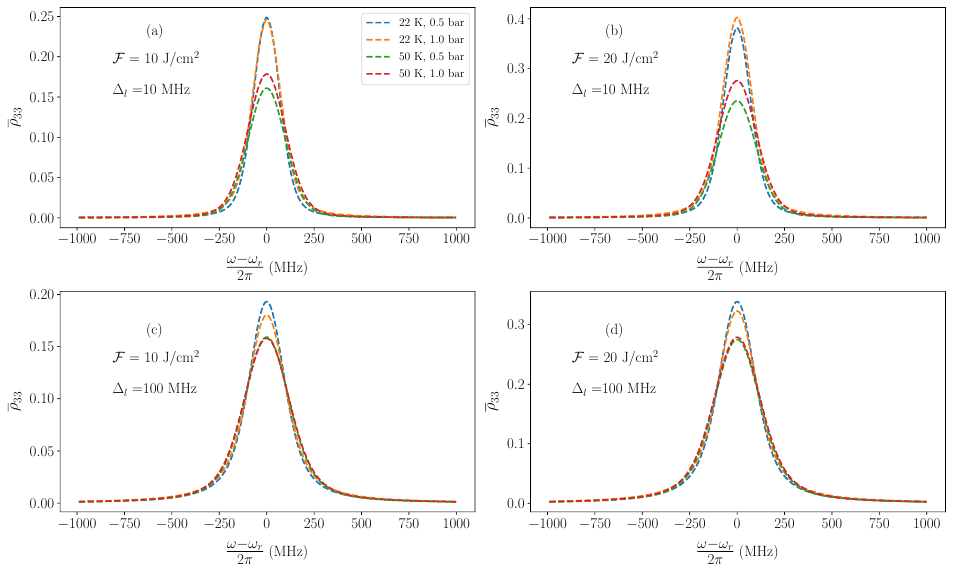
Figure 4: (Color online) ¯ ρ versus the laser angular frequency ω (line-shape) cal- 33 culated by numerically integrating the Bloch equation for τ = 100 ns, at various target conditions assuming Boltzmann distributions between ortho- and para-H : 2 = 10 J / cm 2 and ∆ = 10 MHz; (b) = 20 J / cm 2 and ∆ = 10 MHz; (c) (a) l l F F = 10 J / cm 2 and ∆ = 100 MHz; (d) = 20 J / cm 2 and ∆ = 100 MHz. Values of l l F F ¯ ρ on resonance and FWHM linewidth can be found in Table 33